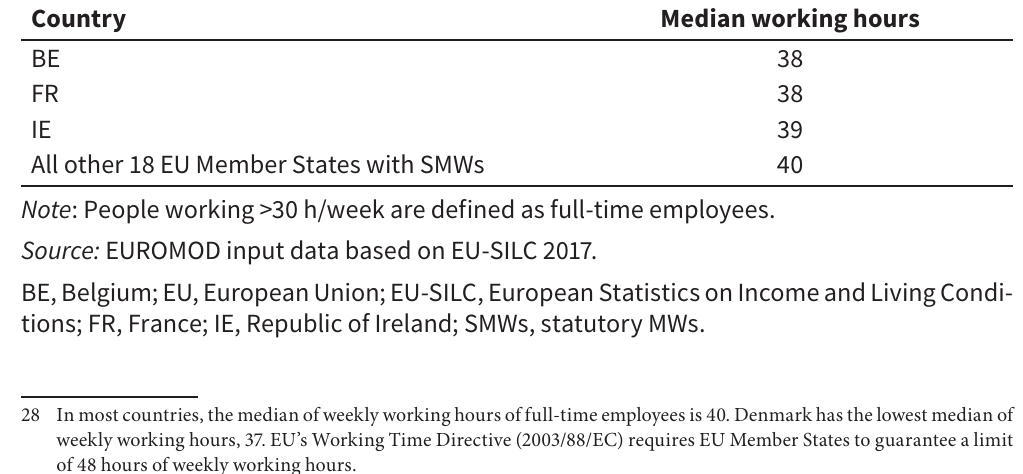
Median number of hours worked by full-time employees Country Median working hours BE 38 FR 38 IE 39 All other 18 EU Member States with SMWs 40 Note : People working >30 h/week are defined as full-time